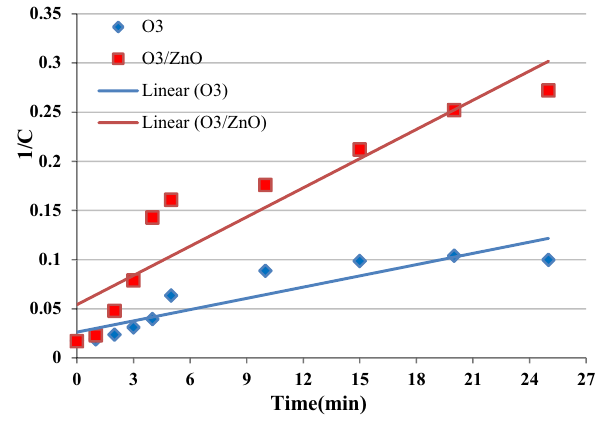
Fig. 13 Testing second-order kinetic for OTC Table 1 The results of experimental kinetic data of degradation in SOP and COP reaction with the first-order equation Type of process